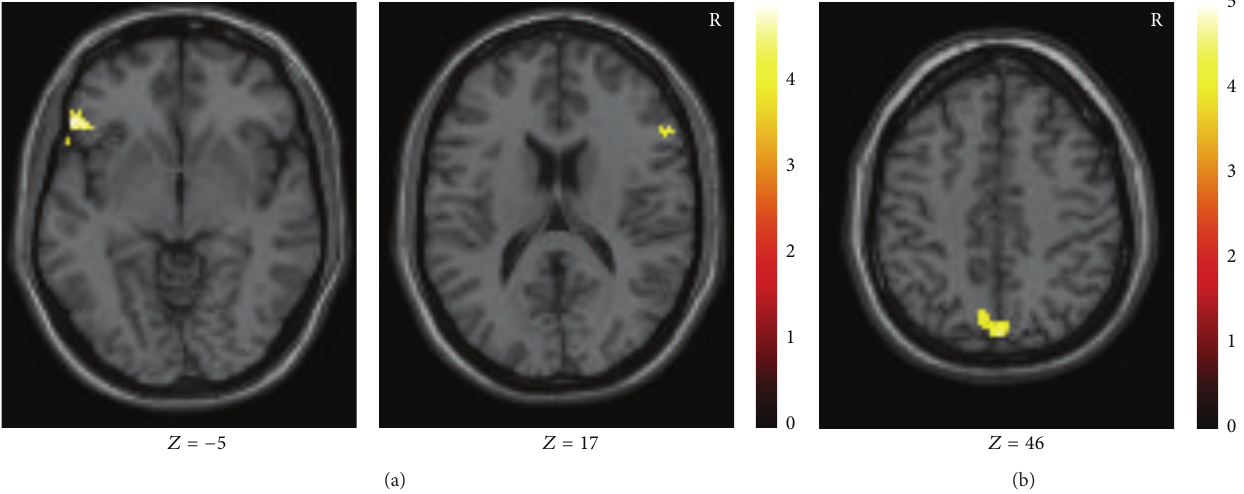
Figure 3: Cortical areas where the blood-oxygen-level dependent signals increased with perceived emotion > passive listening (a) and felt emotion > passive listening (b); cluster threshold 𝑝 < 0.05